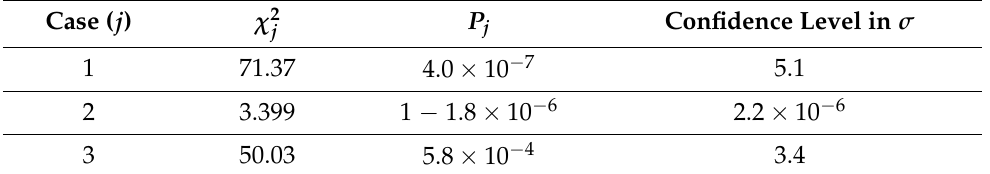
Table 2. Statistical results of the χ 2 analysis for the three hypotheses given in Equation (92) for the form factor B 1 . For each case (first column), we give the corresponding χ 2 (91) (second column), probability P j computed from Equation (93) (third row), and the same P j expressed in terms of confidence levels σ (fourth